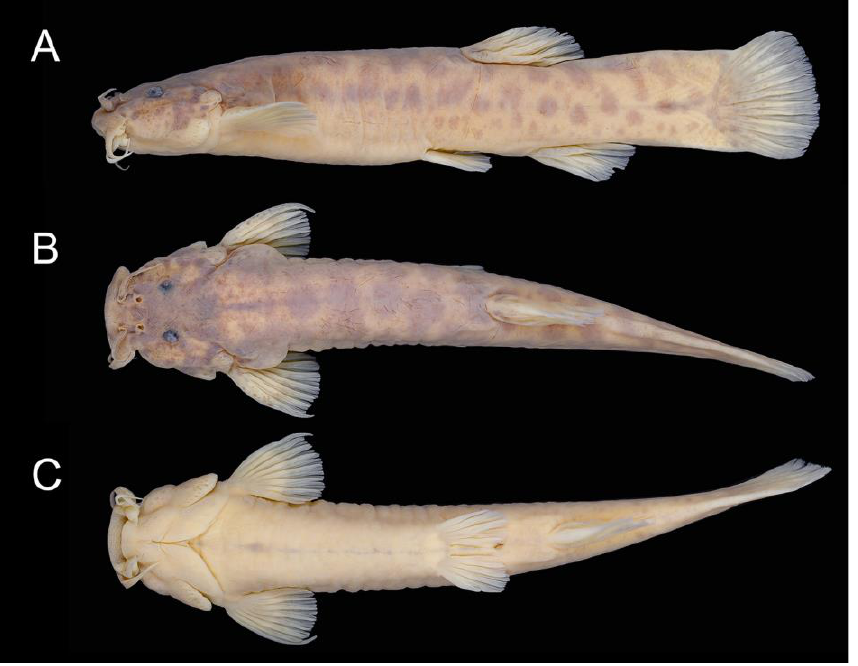
Figure 17. Trichomycterus travassosi , UFRJ 5190, 57.2 mm SL: ( A ) lateral, ( B ) dorsal, and ( C ) ventral views.